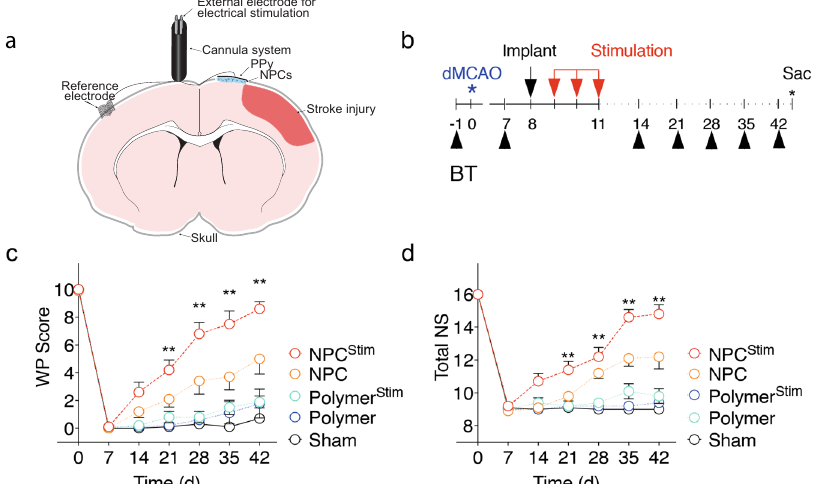
Fig. 1 Electrical stimulation of conductive polymer-stem cell implant improves functional stroke recovery. a Schematic representation of the transplanted conductive polymer-based cannula system (PPy-polypyrole, NPC – neural progenitor cells). b Experimental timeline with training three times in the week prior to dMCA occlusion. Black arrows indicate behavioral testing (BT). Red arrows indicate stimulation after implantation. c Vibrissae-forepaw (WP) behavioral testing. There is a statistically signi fi cant difference in WP Scores between NPC Stim and Polymer Stim , Polymer, and Sham groups at 3 weeks post-stroke, and a signi fi cant difference in WP Scores between NPC Stim and all other groups at 4 weeks post-stroke and onward. d Total neurological score (NS) testing. NPC Stim exhibited signi fi cant difference in NS at individual timepoints 3 weeks post-stroke and beyond, in comparison to the NS of all other groups; moreover, there was a signi fi cant difference in NS Scores between NPC Stim and Polymer Stim , Polymer, and Sham groups at 3 weeks post-stroke and onward. c Analyzed using a log-transform two-way repeated measures ANOVA, which revealed a statistically signi fi cant interaction between the effects of treatment group and WP Scores ( F [24, 270] = 8.379, P <0.0001), followed by Dunnett ’ s multiple comparisons test. d Analyzed using Kruskal – Wallis test ( P < 0.0001), followed by Dunn ’ s multiple comparisons test. For both, ** P <0.01, data shown as mean±SEM, n = 10 per